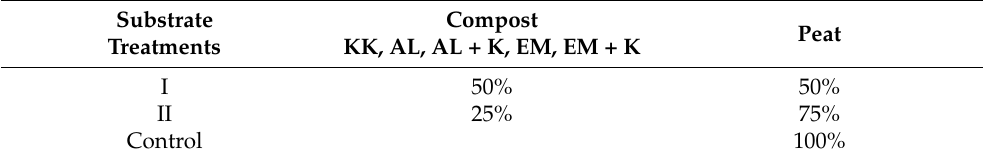
Table 4. The combinations of